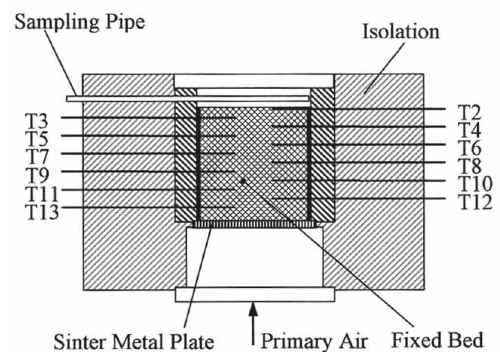
Figure 2: Schematic image of the combustion